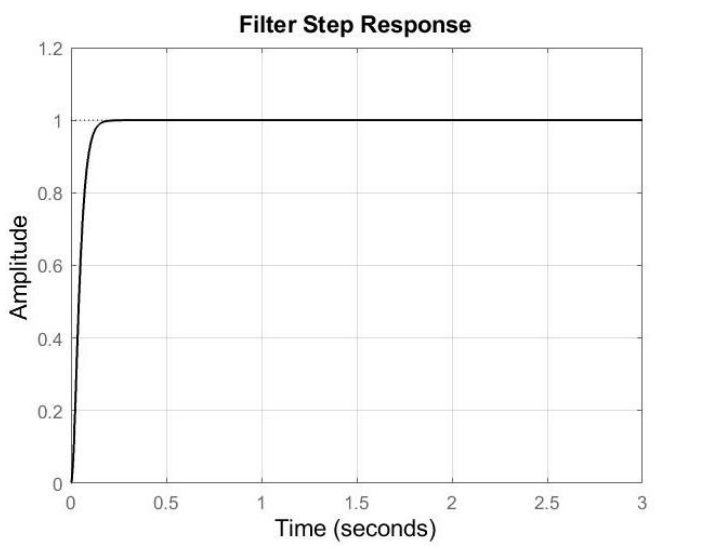
Figure 7. Low-pass filter step response, representing the ideal system